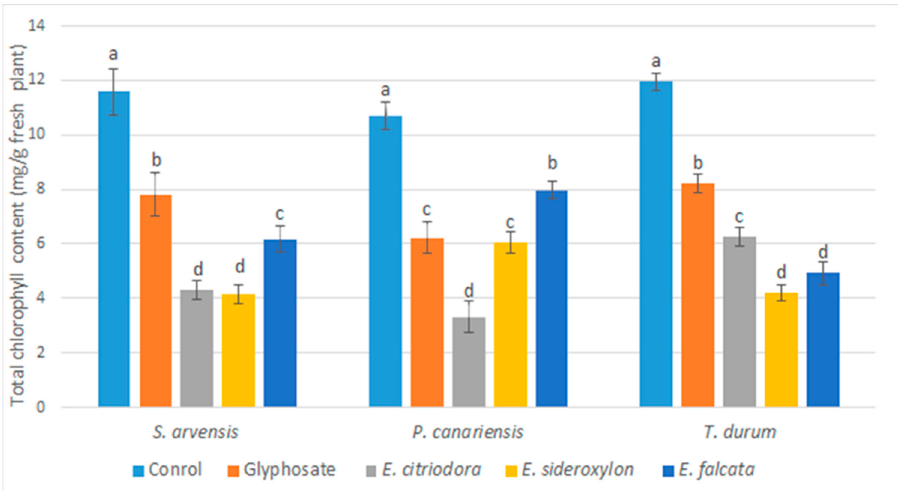
Figure 4. Effects of Eucalyptus species essential oils and glyphosate on total chlorophyll content as mg/g fresh tested plants measured five days after application. Error bars and letters on graphs represent standard error means and significant differences at p ≤ 0.05 through Student–Newman–Keuls.